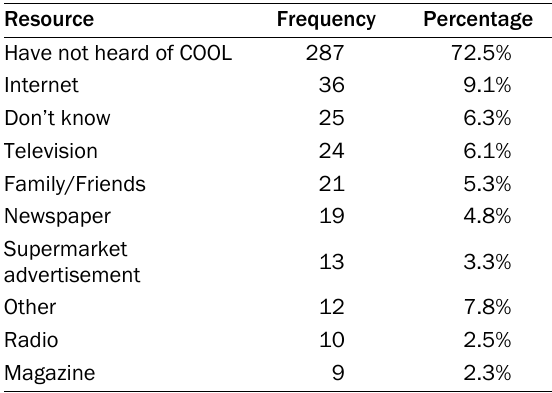
Table 2. Resources Providing Information